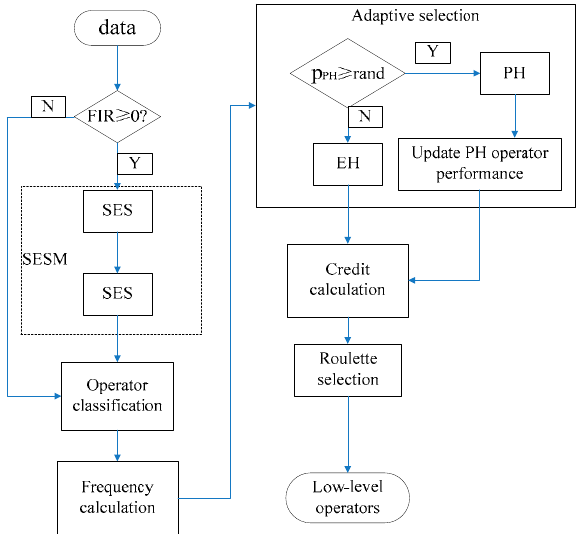
Figure 4. Framework of the second exponential smoothing (SESMAM).